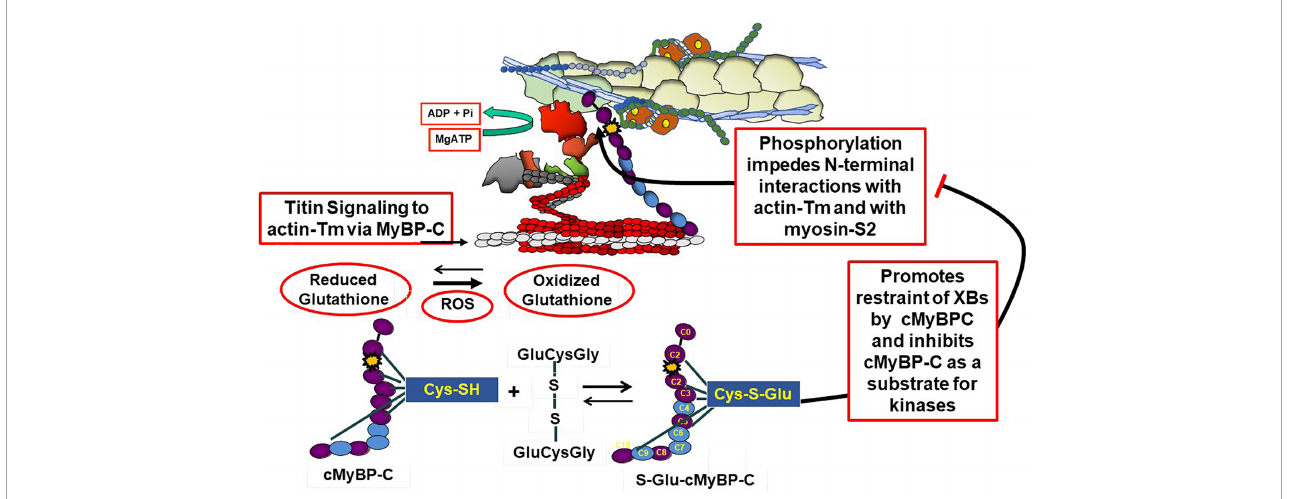
FIGURE2 Modulation of cMyBP-C by phosphorylation and oxidative stress. The top panel shows an active sarcomere emphasizing cMyBP-C interactions at the N-terminal domains with the thin filament and myosin and C-terminal domains interacting with tails of myosin and titin. These interactions are inhibited with site specific phosphorylations (yellow star) of an N-terminal domain (yellow star) and modulated by oxidative stress demonstrated by the action reactive oxygen species (ROS) to increase the ration of reduced glutathione to oxidized glutathione. As shown the oxidized glutathione reacts with available Cys residues generating S-glutathionylated (S-Glu) cMyBP-C, which, as discussed in the text, may block the effects of phosphorylation to increase cross-bridge kinetics. Cys residues identified in various studies (41, 42, 57) are shown to exist in N-terminal and C-terminal regions as well as domains in the middle panel .